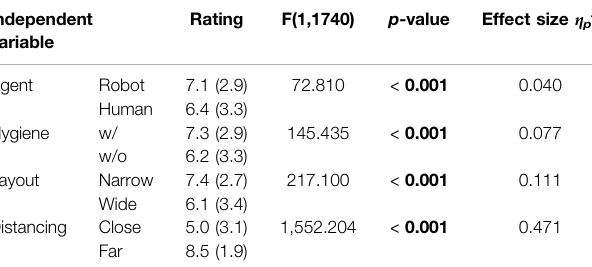
TABLE 1 | ANOVA results (main effects). Signi fi cant p -values are bolded. Independent variable